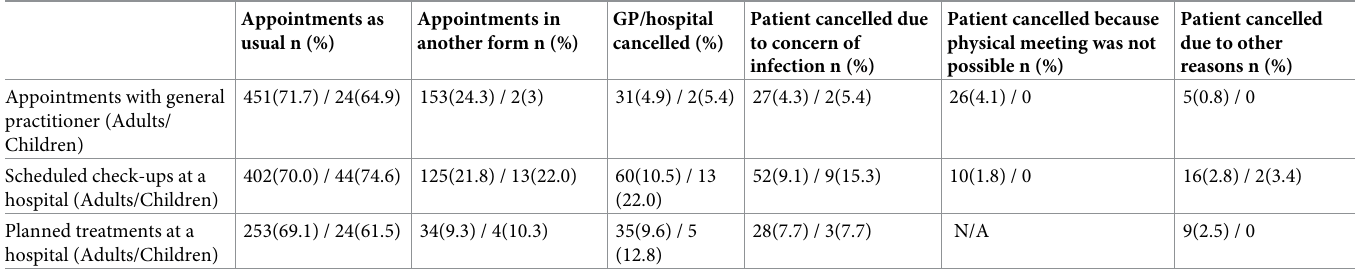
Table 3. Medical and hospital visits during the COVID-19 pandemic among adults and children who had appointments in the